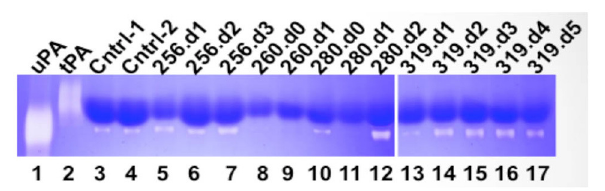
FIGURE 2 | Qualitative zymography used to determine active tPA and uPA in plasma drawn from Class III HCPS cases (256, 260, 280, and 319). Coomassie blue stained zymogram reveals sites of proteolysis as white bands on a dark blue background. Data indicates active uPA in HCPS cases (note lanes 7, 12, 14, 15, 16, and 17). tPA activity was not detected. Although control samples indicate active uPA, the HCPS cases are notable, because of high levels of circulating PAI-1 in these subjects ( Table 1